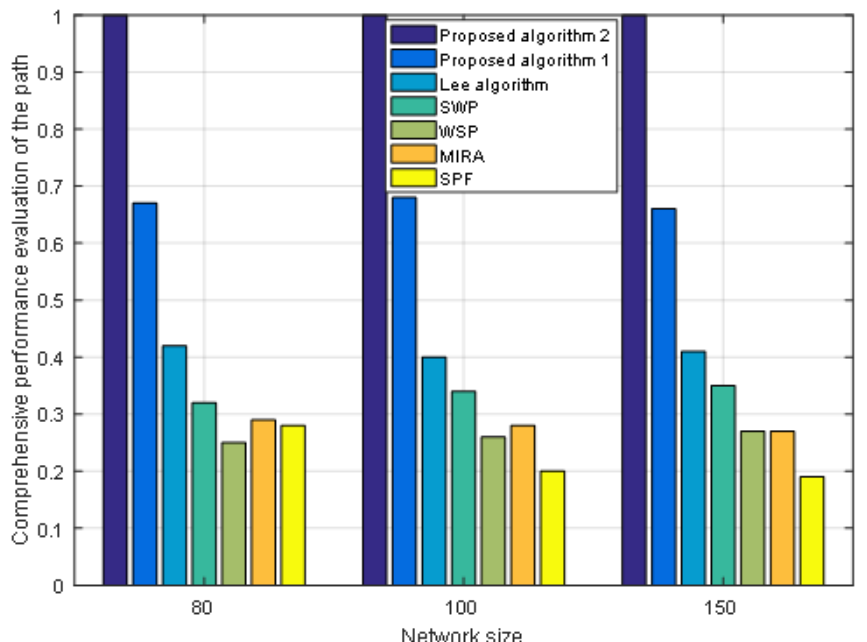
Figure 10. The comprehensive performance evaluation of path under different network